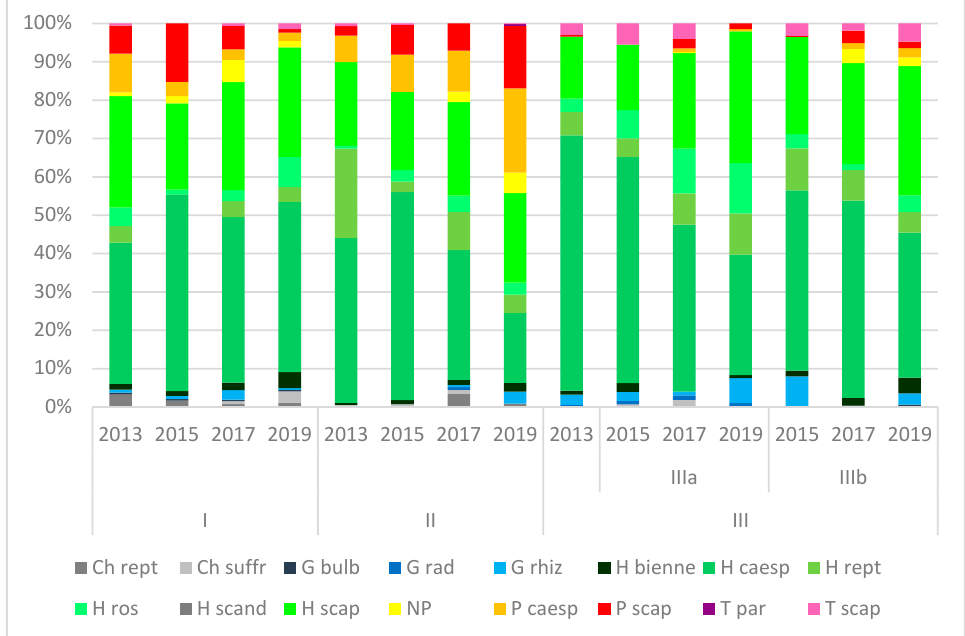
Figure 2. Distribution of Pignatti lifeforms of the taxa in the areas I-III. Ch: chamaephyte; G: geophyte; H: hemicriptophyte; NP: nanophanerophyte; P: phanerophyte; T: therophyte. rept: reptant; suffr; suffruticose; bulb: bulbose; rad: radose; rhiz: rhizomes; bienne: biennial; caesp: caespitose; ros: rosette; scand: scandose; par: parasitic.